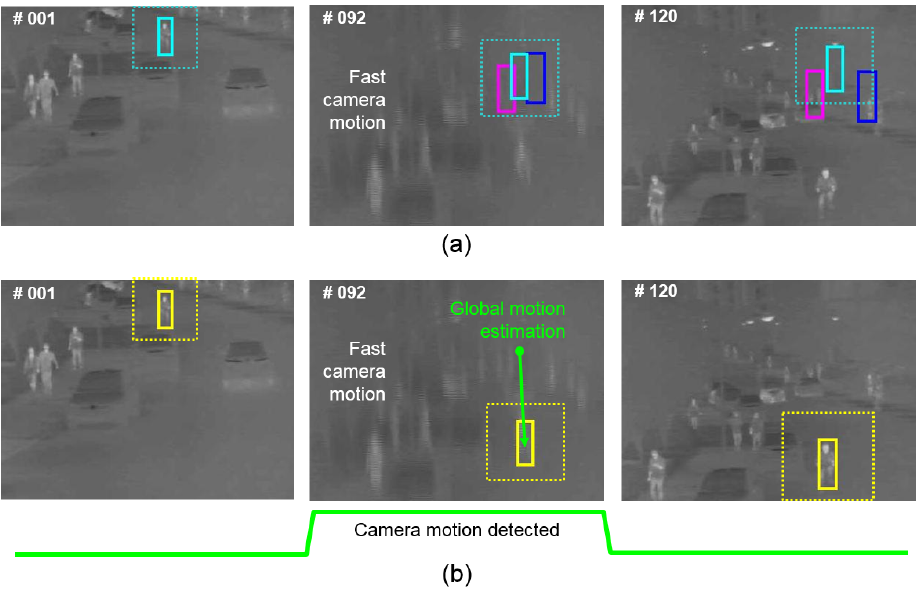
Figure 1. Conventional trackers fail due to the fast camera motion, and they are no longer able to recover the target position ( a ). The proposed tracker can handle large target movements caused by the camera motion and can successfully track the target ( b